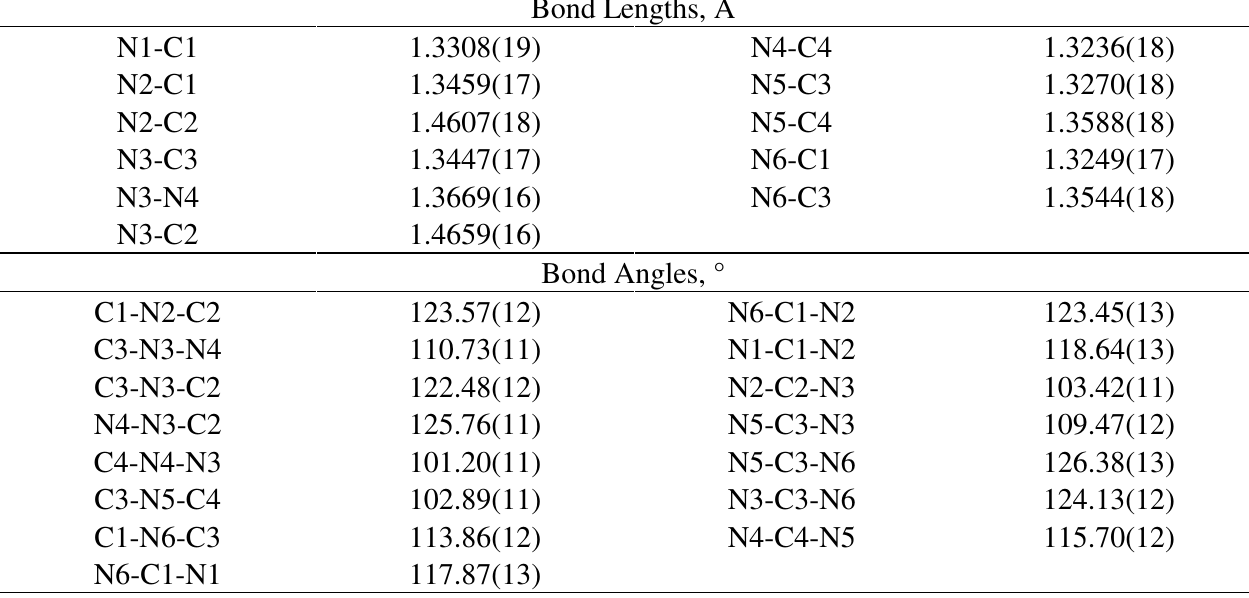
The triazine ring C1/N2/C2/N3/C3/N6 in the molecule adopts a flattened boat conformation with atoms C2 and N6 at the bow and stern. The angle C10-C2-C11 between the flagpole and bowsprit geminal methyl groups is 111.88(13)°. This value is within the range (111.33–112.40) observed for the structurally related molecules